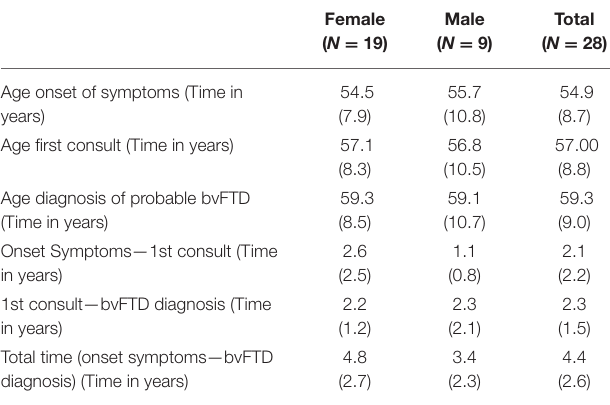
TABLE 3 | Time lapses between onset of symptoms and diagnosis [Mean